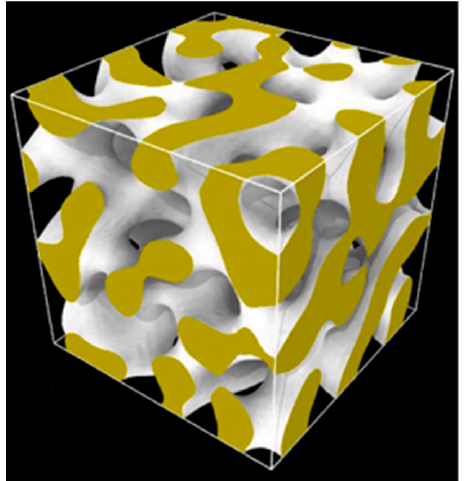
Figure 1. The small sample microstructure and morphology. This template was scaled as is to produce the larger sample which ended up having same porosity and network connectivity, but with different ligament size (solid surface is white and interior of solid is gold).